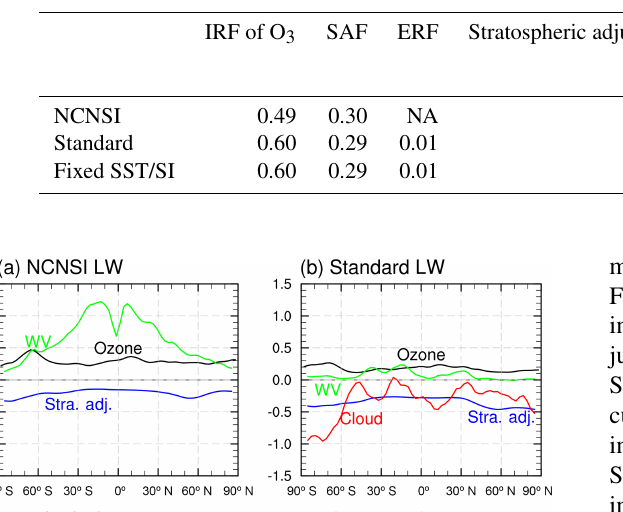
Table 1. Radiative forcing and adjustments, evaluated at the top of the atmosphere. The columns indicate the instantaneous radiative forcing (IRF) of O 3 , the stratosphere-adjusted forcing (SAF), the effective radiative forcing (ERF, i.e., stratosphere and troposphere-adjusted forcing), the stratospheric adjustment, and the radiation changes caused by cloud, sea ice, atmospheric temperature ( T A ) , water vapor (WV), and surface temperature ( T S ) , respectively. Unit: Wm − 2 .